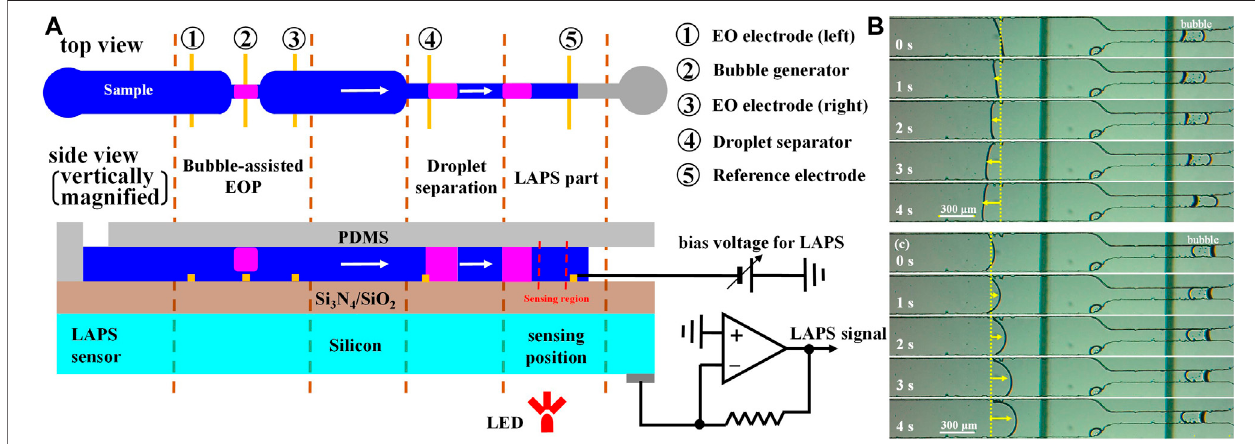
FIGURE 10 | (A) Microelectrochemical analysis system with a LAPS as the sensing unit and a bubble-assisted electroosmotic micropump as the fl uid driving unit; Bubble-assisted EO fl ows in (B) left and (C) right directions depending on the polarity of the pumping voltage (Li et al.,